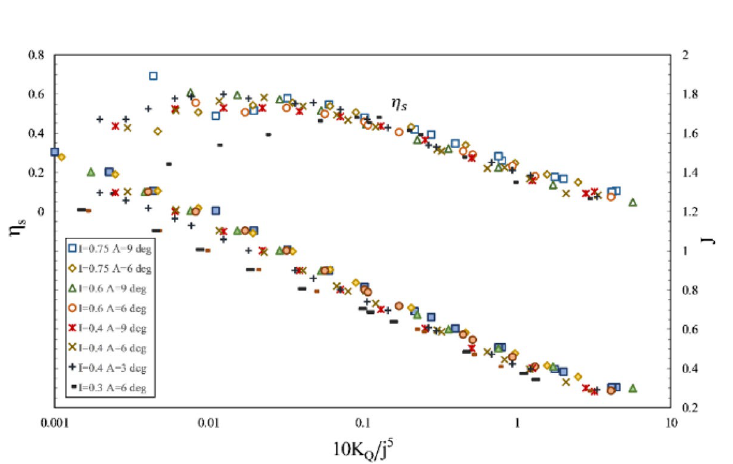
Figure 23. Variation of thrust coefficient in the propulsion direction at different immersion ratios and inclination angles.